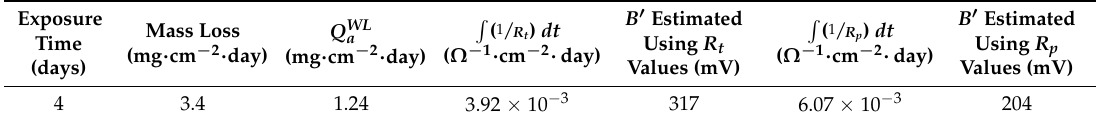
Table 4. ‘Apparent’ Stern–Geary coefficient values B (cid:48) , calculated from EIS-estimated R t or R p values for AZ31B magnesium alloy immersed in Ringer’s solution (37 ◦ C) up to 4 days and anodic charge Q WL a determined by mass loss of the EIS tested